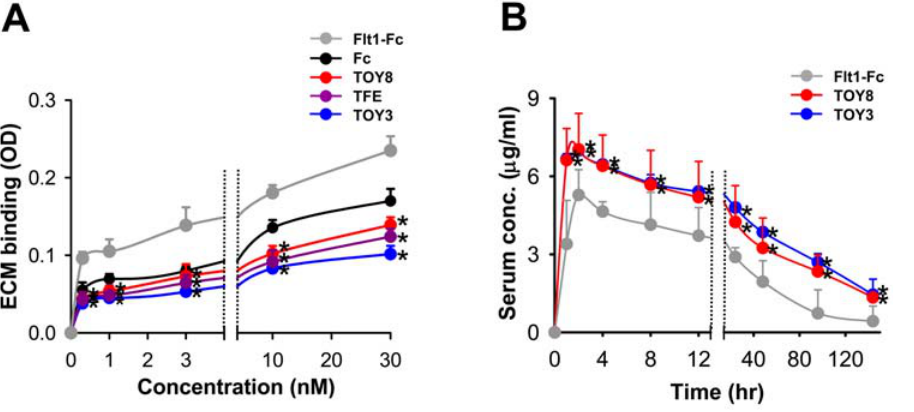
Figure 5. TOY3 and TOY8 have low binding affinity to ECM invitro and display excellent pharmacokinetic profiles invivo . ( A ) ELISA analysis depicting the binding affinity for different concentrations (0.3, 1, 3, 10, 30 nM) of each indicated protein to ECM. Values are given as means 6 S.D. ( n =4). *, P , 0.05 versus Fc. ( B ) Pharmacokinetic profiles. The indicated protein (5 mg/kg) was injected intraperitoneally into C57BL/6 mice. Then blood samples were taken from the tail vein at 1, 2, 4, 8, 12, 24, 48, 96, and 144 hrs, and serum levels of the proteins were measured by ELISA. Values are given as means 6 S.D. ( n =4). *, P , 0.05 versus Fc.